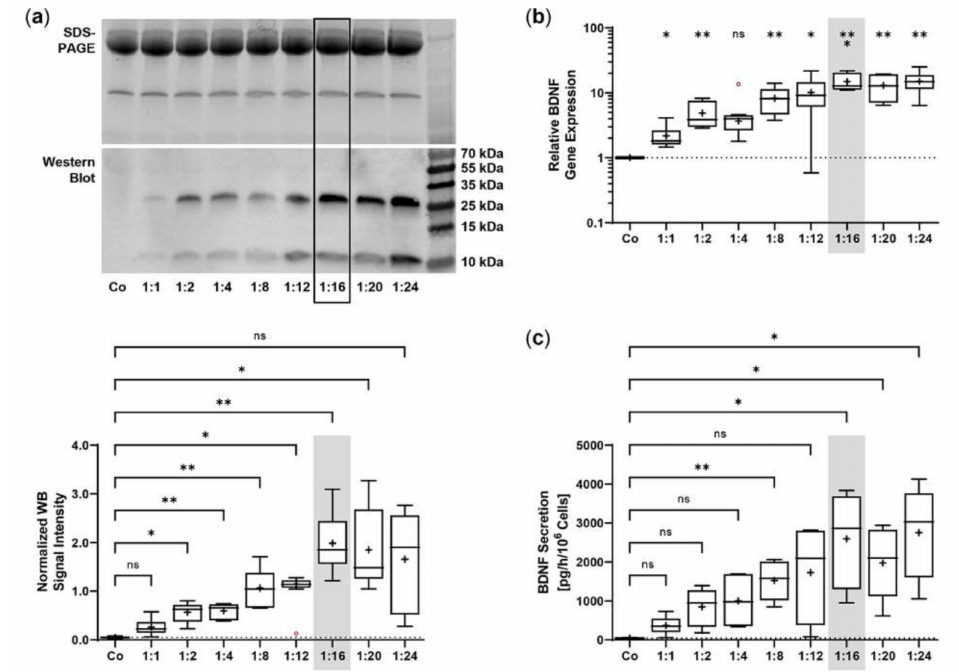
Figure 1. Transfection of ARPE-19 cells using different ratios of SB100X transposase plasmid and BDNF transposon plasmid. In each experiment ( n = 6), 1 × 10 5 cells were transfected with an in- creasing ratio (1:1–1:24) of SB100X transposase to BDNF transposon plasmid at a total concentration of 0.5 µ g, plus one control without the addition of plasmid DNA (Co). Cultures were